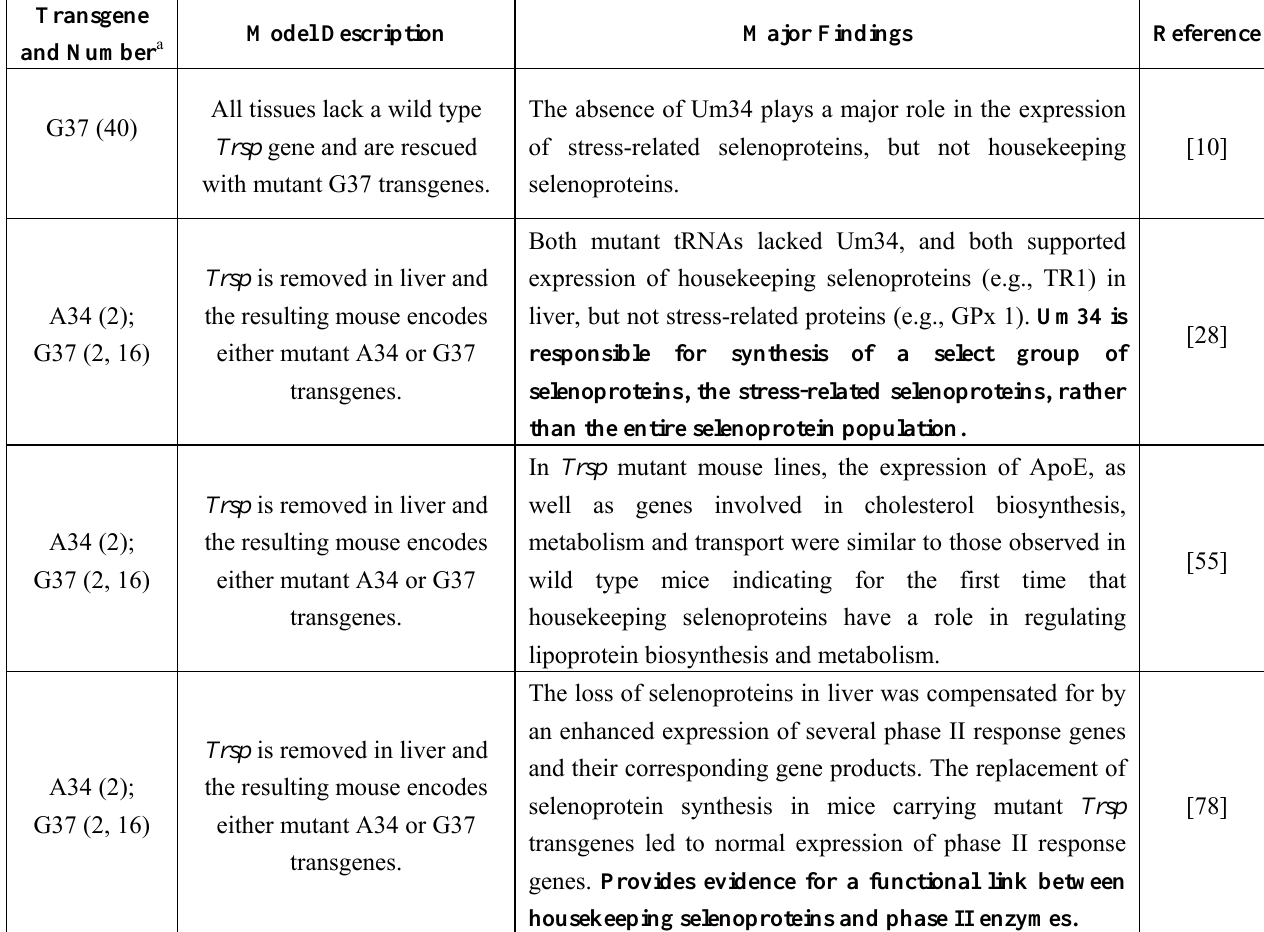
Table 3. Mutant Trsp transgenic/standard or transgenic/conditional knockout mouse models .